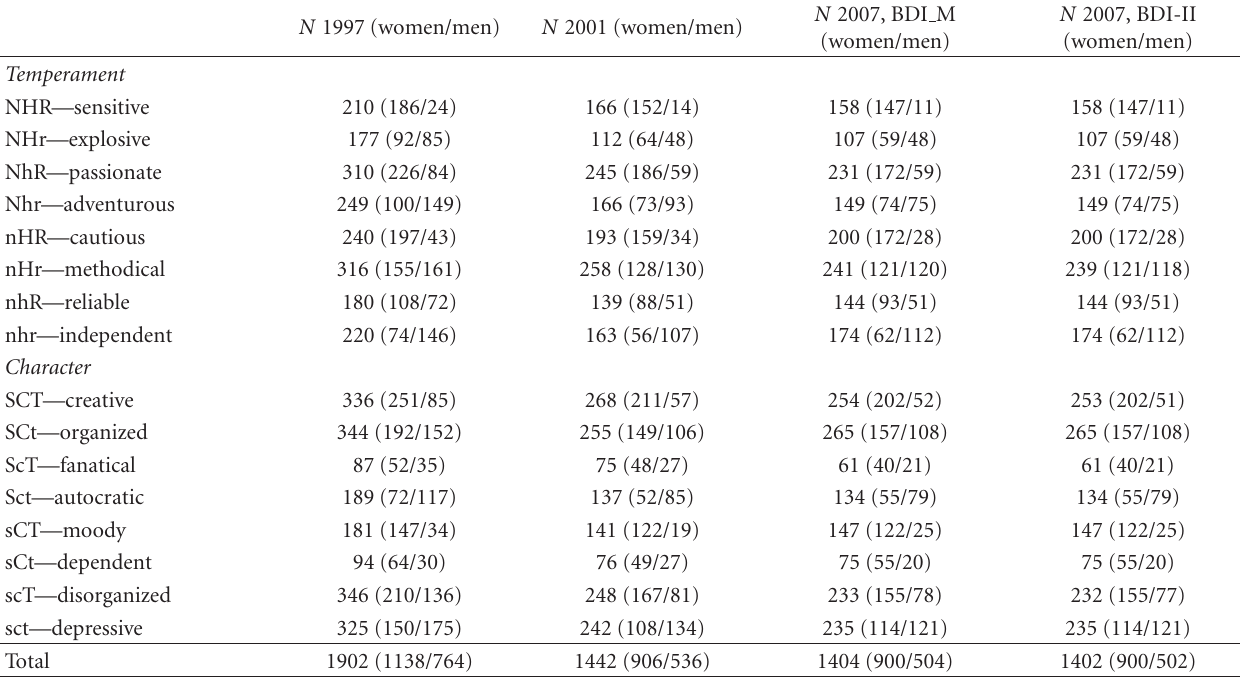
Table 1: Frequency distribution of TCI